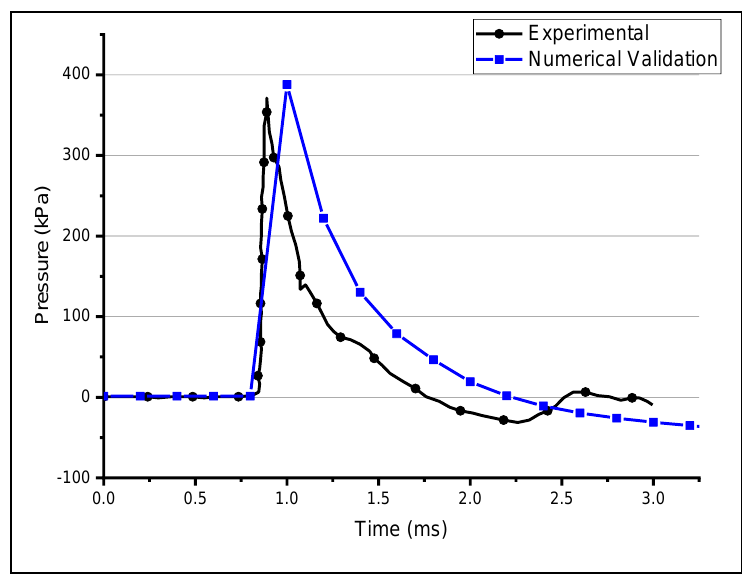
Figure 7. Pressure-time history from simulation and air blast experiment results [80].